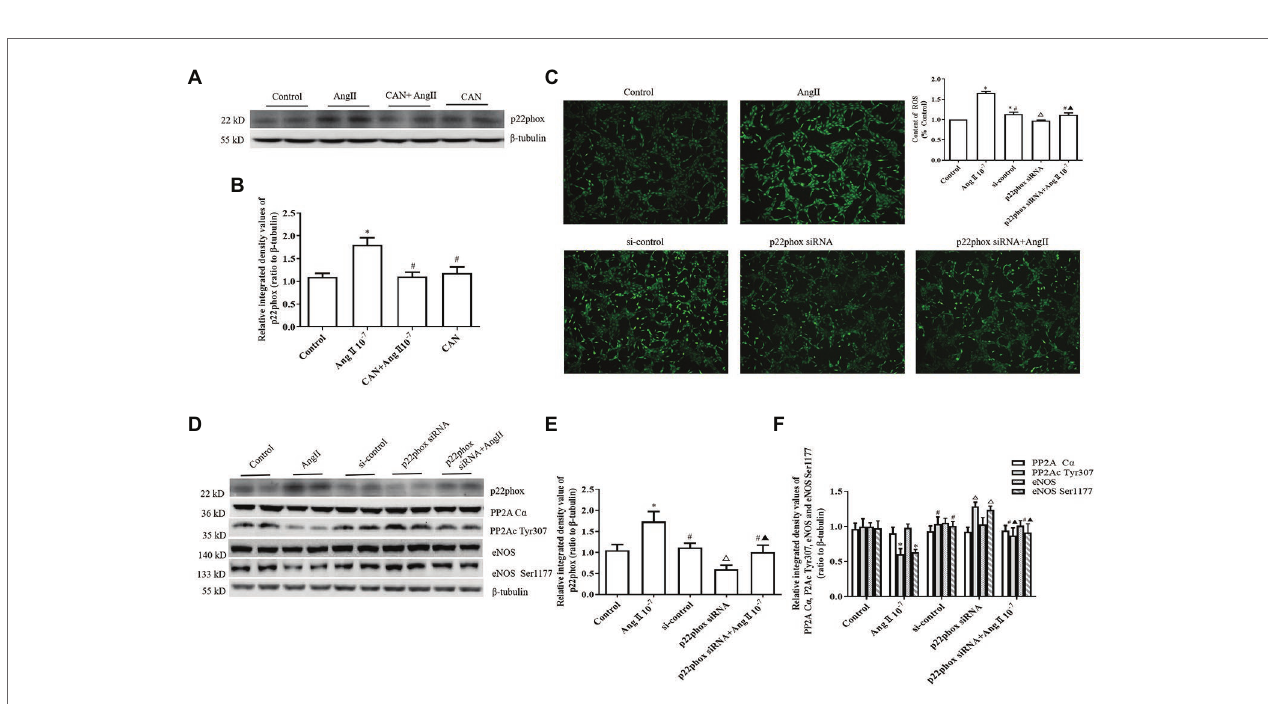
FIGURE 3 | (E,F) ROS content was enhanced by AngII (10 −7 M, 12 h) and abolished by pretreatment with CAN (10 −6 M, 3 h). HUVECs were incubated with DCFH-DA (5 μ mol/L) for 30 min, and ROS content was measure. The representative images shown were captured using a fluorescence microscope (100× magnification; n = 4 independent experiments). Pretreatment with the antioxidant, (G,H) N-acetylcysteine (NAC; 10 −3 M, 1 h) and (I,J) Apocynin (APO; 2 × 10 −5 M, 1 h), inhibited AngII/ AT 1 R-mediated downregulation of PP2Ac Tyr307 and eNOS Ser1177 ( n = 6 independent experiments). * p < 0.05 vs. Control or Sham group; # p < 0.05 vs. AngII